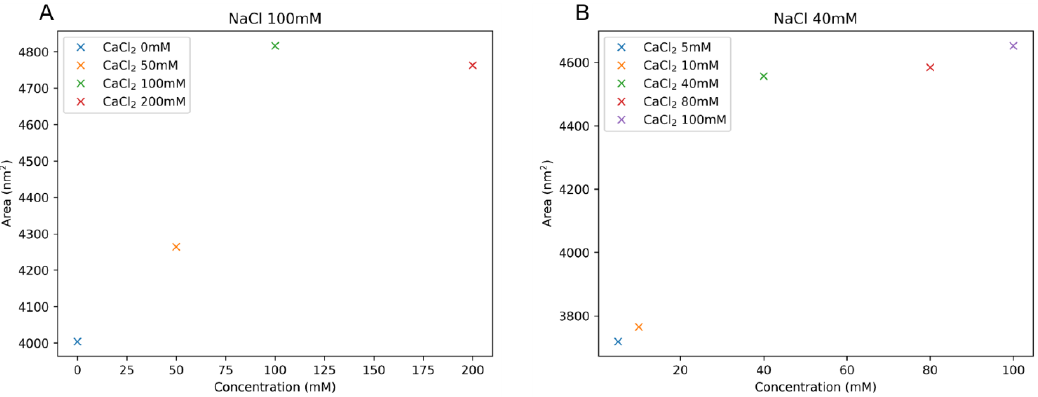
Figure 9. Area of HA gel when the concentrations of NaCl are ( A ) 100 mM and ( B ) 40 mM. The area is plotted as a function of CaCl 2 concentration.